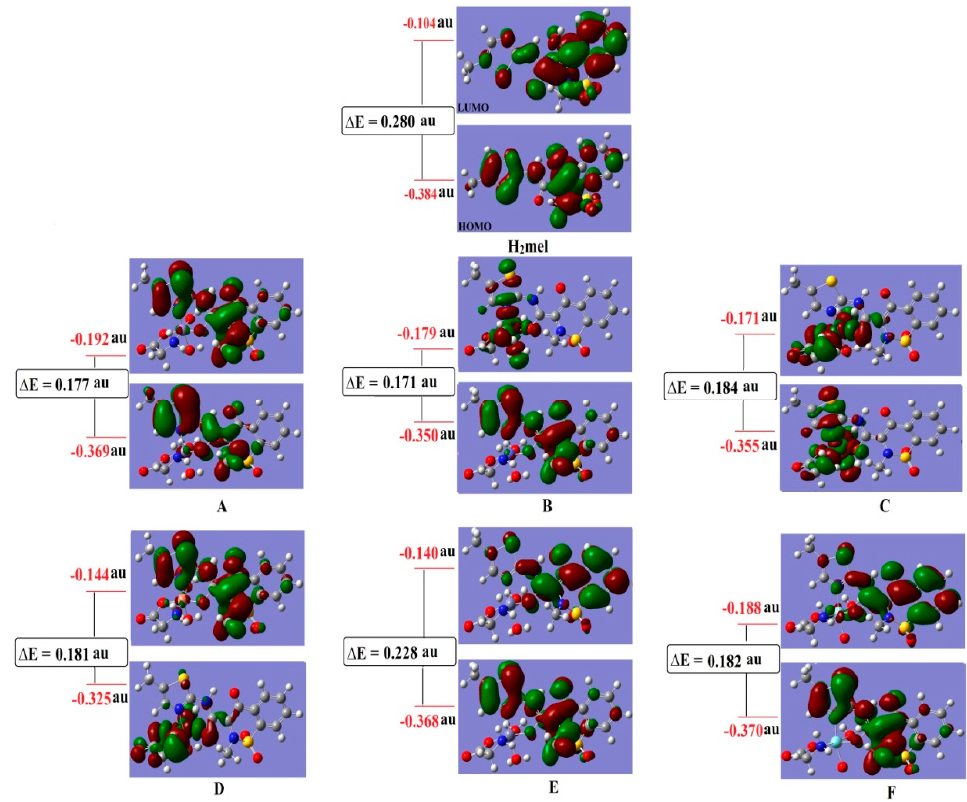
Figure 4. Molecular orbital surfaces and energy levels of H 2 mel and their metal complexes. Where, ( A) = Mn(II) complex, ( B) = Co(II) complex, ( C) = Ni(II) complex, ( D) = Cu(II) complex, (E) = Zn(II) complex and ( F) = Zr(IV) complex.